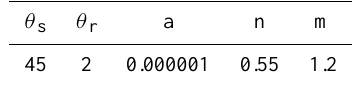
Figure 9a. Influence of the presence of the structure on the variation of soil suction